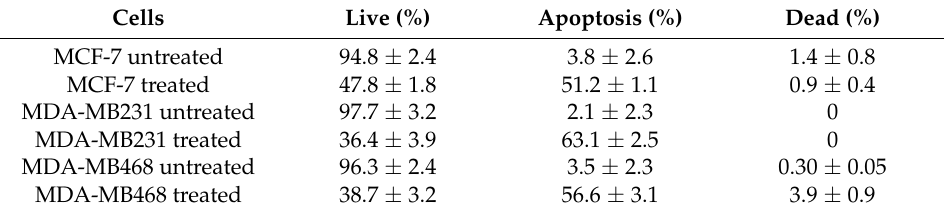
Table 1. Apoptosis. Percentage of live, apoptotic and dead cells expressed as mean ± standard deviation by the Muse Annexin V and Dead Cell assay in MCF-7, MDA-MB231 and MDA-MB468 cells after treatment with IC 50 concentrations obtained after 48 h. Untreated cells were used as control. Cells Live (%)